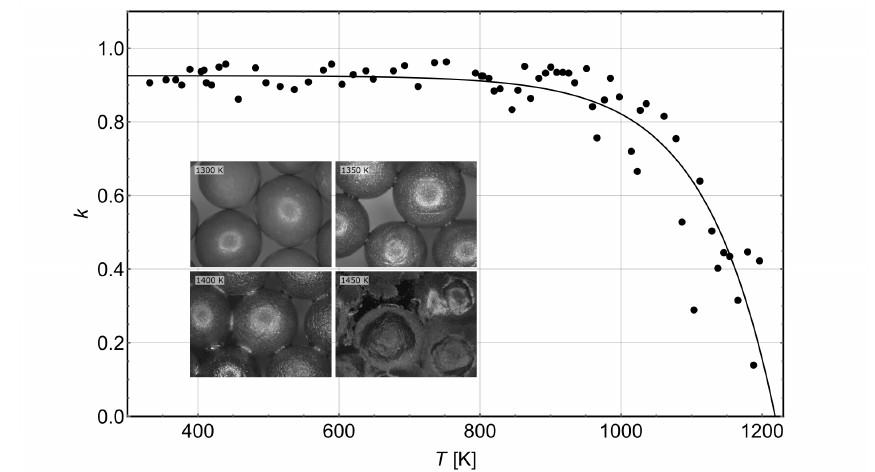
Figure 7. Coefficient of restitution ( k ) for collisions between a hot mm basalt sphere and a cold glass target on the ground. The collision velocity was about 1 m/s. The inset shows the onset of